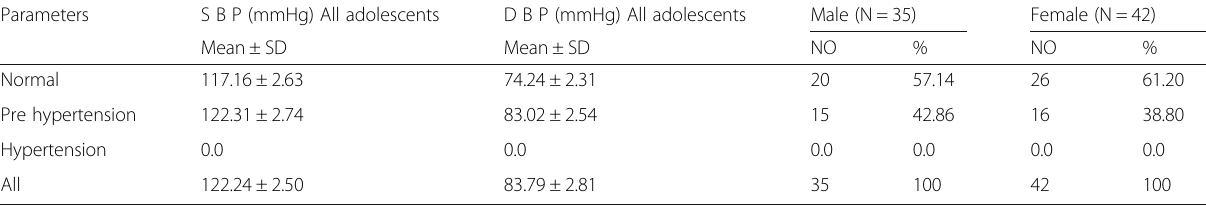
Table 2 Distribution of the obese adolescents under study according to Blood pressure levels Parameters